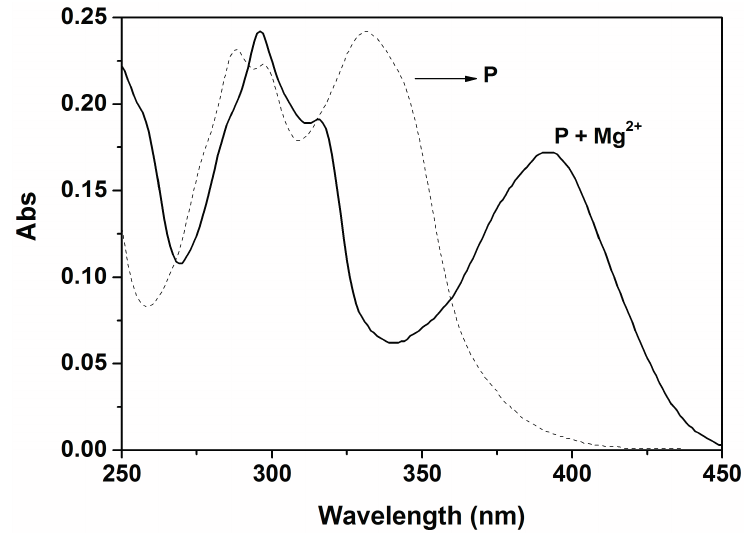
Figure 2. UV-vis spectra of P (10 μ M) in ethanol-water solution (9:1, v:v, 20 mM HEPES, pH 10.0) upon addition of 100 μ M Mg 2+ .